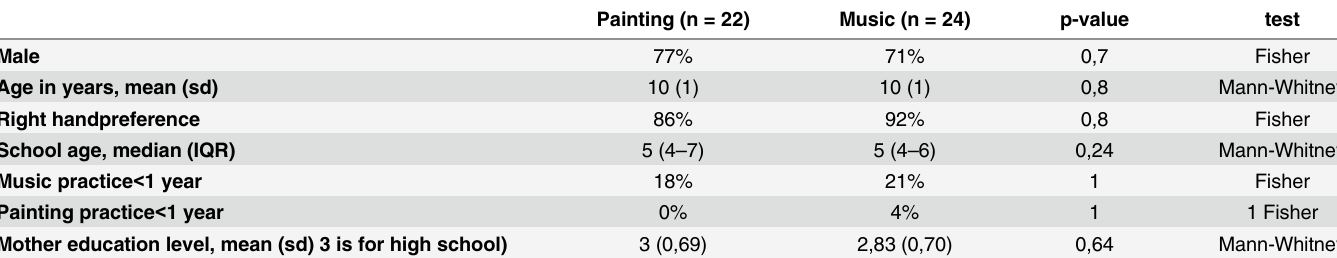
Table 1. General description of the two groups.